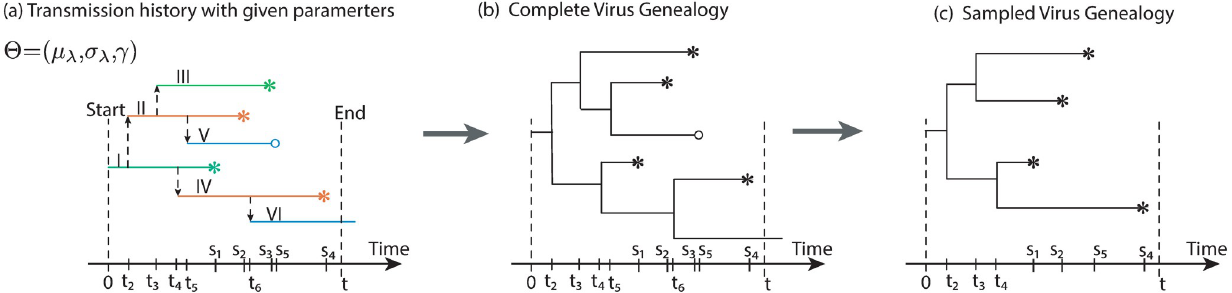
Fig 1. The connection between transmission history H (a), complete genealogy G (b), and sampled genealogy G ð S Þ (c). In the model, a transmission history (a) is simulated with the heterogeneous birth-death transmission model under a given set of parameters ( Θ ). The i -th ( i = I , ��� , V in Roman numeral notation) individual was infected and stopped infection at t i and s i ( i = 1, ��� , 5 in Arabic numerals) respectively. There are three categories of individuals at the end of the simulation: sampled individuals, i.e. diagnosed and sequenced (tips labeled with − � ), diagnosed but unsampled individuals (tips labeled with − � ), and undiagnosed individual (unlabeled tips). A complete virus genealogy G (b) contains the genealogical lineages from all the infected individuals. In the case of no within host diversity it coincides with the transmission tree T being the transmission history H but without the direction of transmission. The sampled genealogy G ð S Þ (c) is derived from the complete genealogy by removing edges from unsampled individuals.